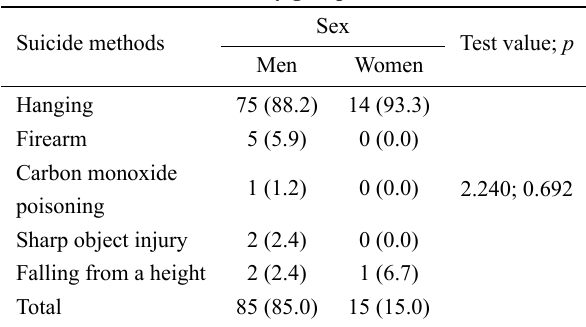
Table 3. Comparison of gender and suicide methods in the study group.